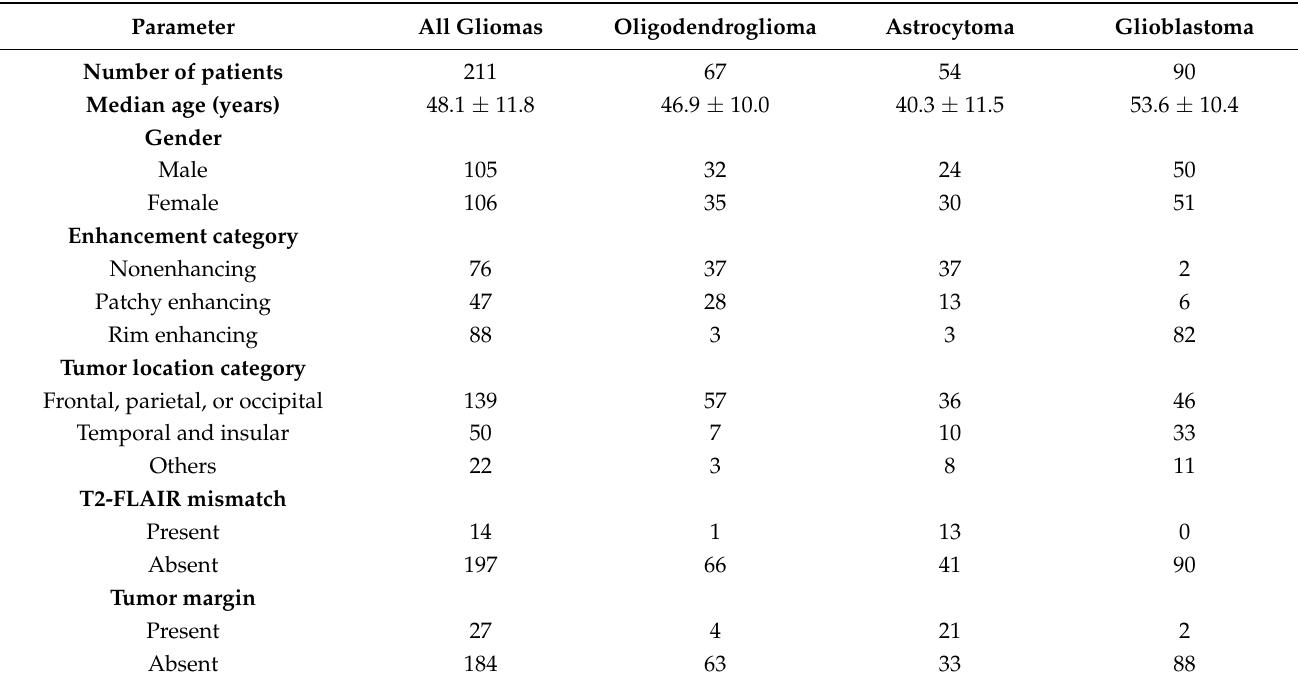
Table 2. Numeric data of the patients included in the